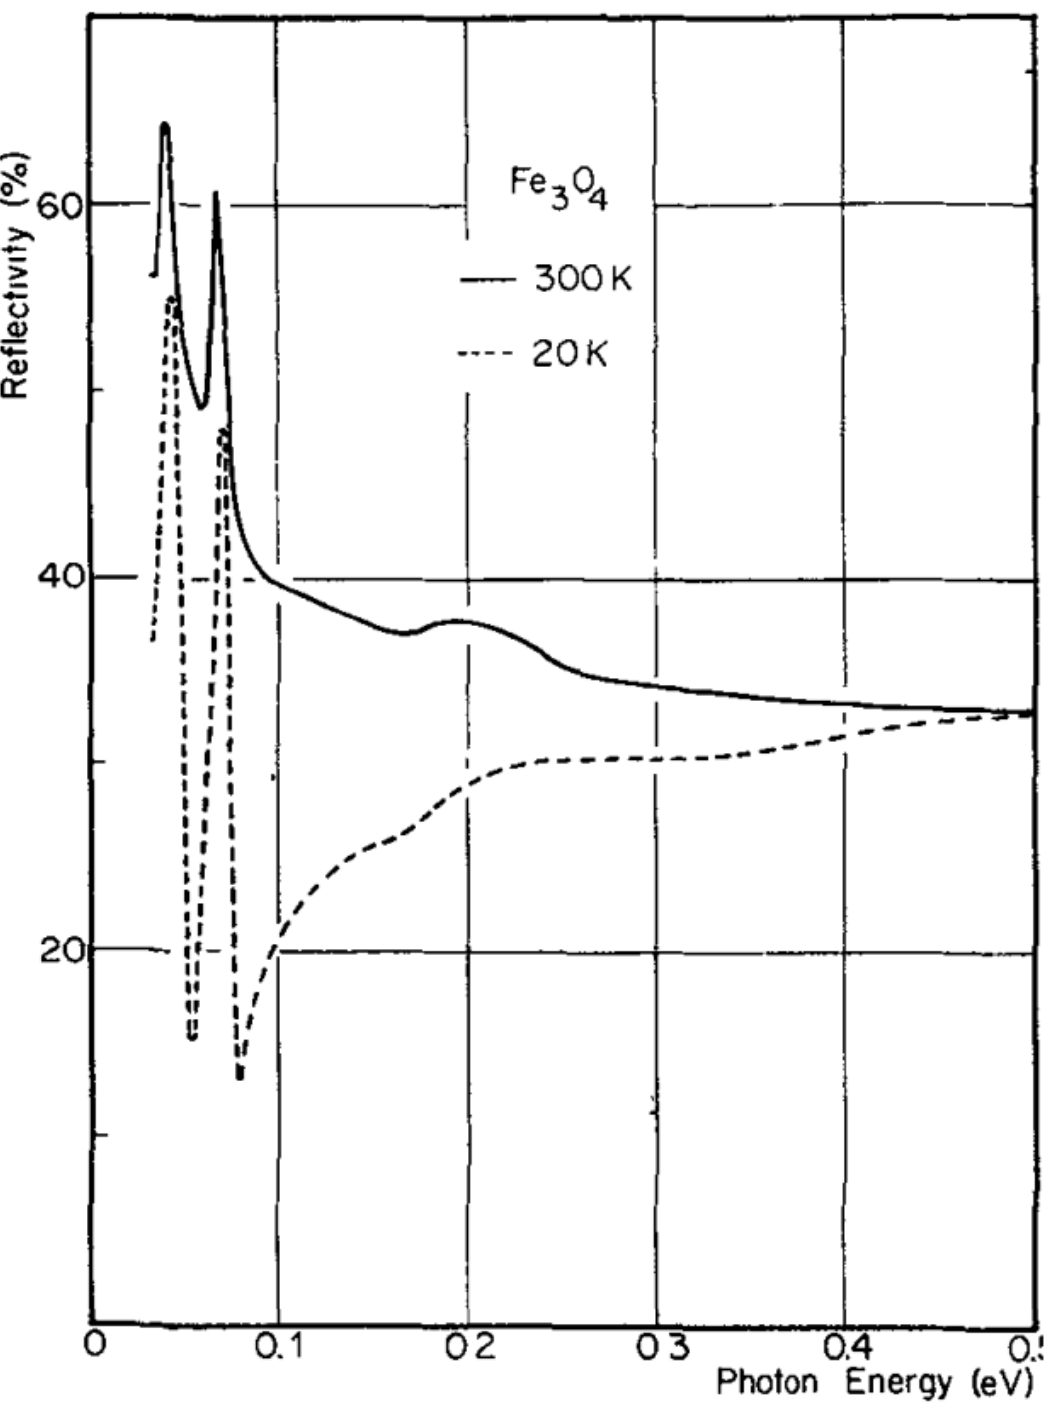
Figure 5. Reflectivity of Fe 3 O 4 in the infrared energy range [35].